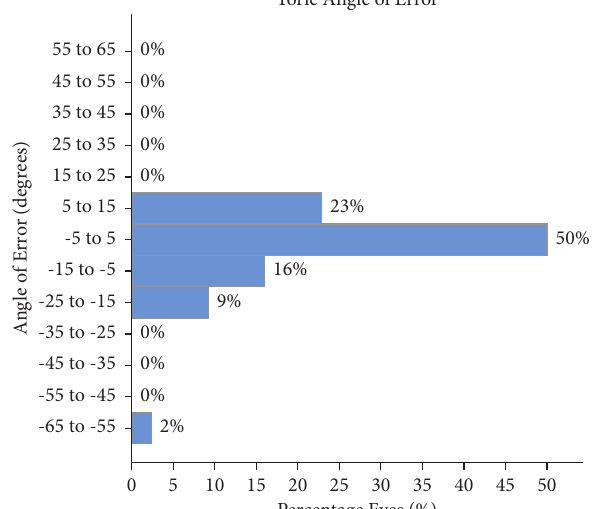
Figure 3: Assessment of the toric angle of error with 48% of the eyes within ± 5 degrees, 20% between 5 and 15 degrees of counterclockwise rotation and the remainder rotated